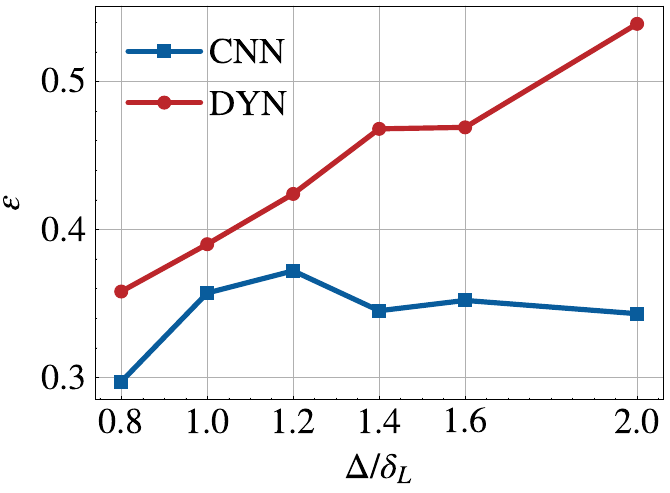
Figure 12. CNN and DYN model errors on R2 for various filter